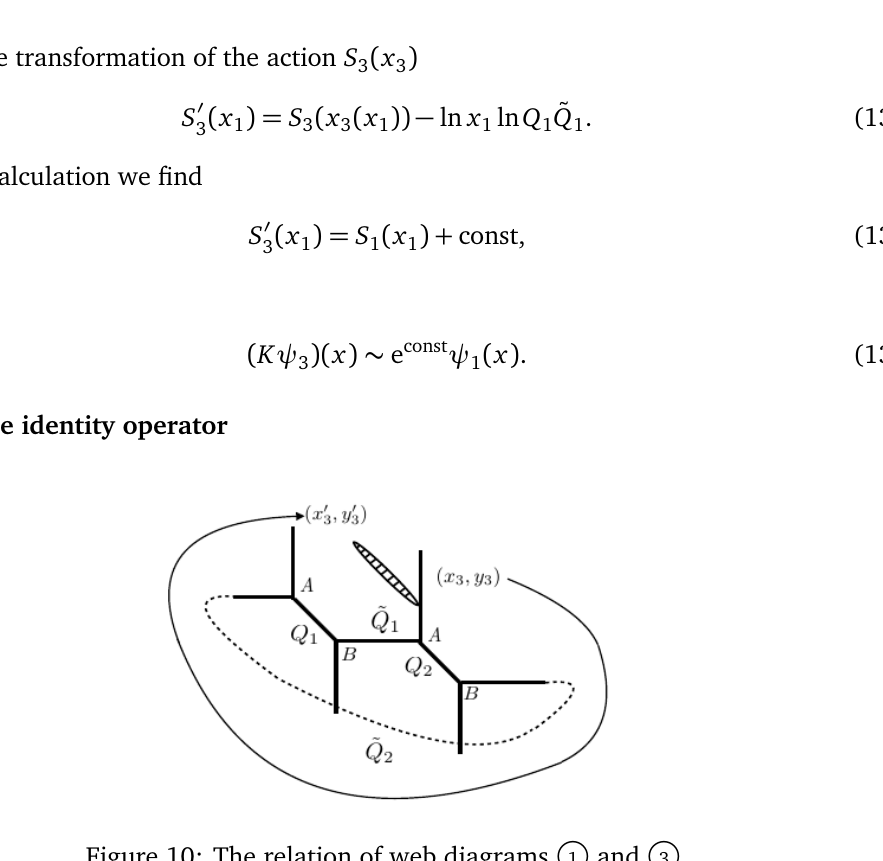
Figure 10: The relation of web diagrams 1 (cid:13) and 3 (cid:13)